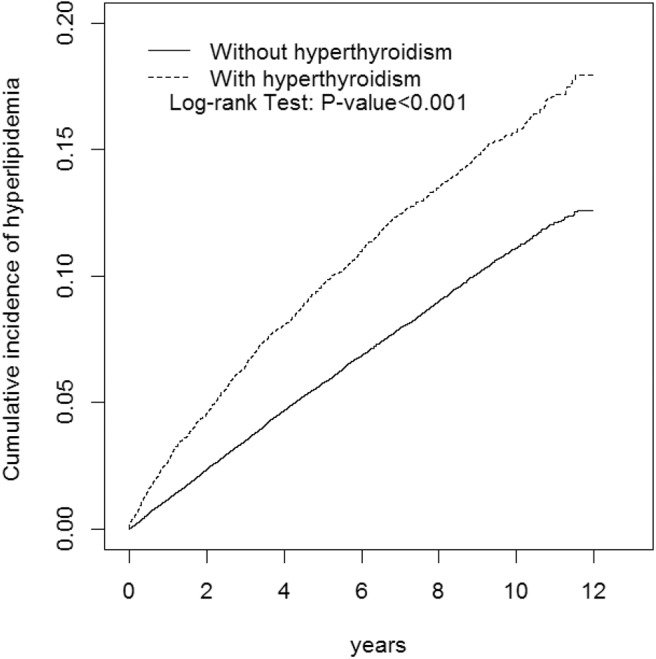
Cumulative incidence of hyperlipidemia compared between with and without hyperthyroidism using the Kaplan-Meier method. Case group mean follow-up years 5.96 (SD = 3.53). Control group mean follow-up years 6.08 (SD = 3.49).